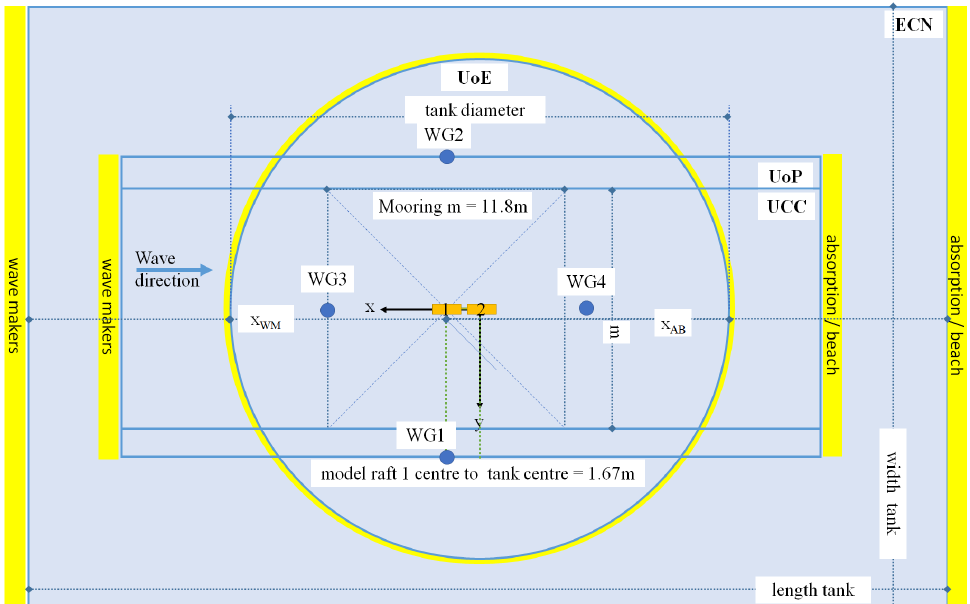
Figure 3. Scaled comparison of the four different tank setups with the values provided in Table 3. Note that WG2 was moved to the nominal model location for the “open tank” characterisation